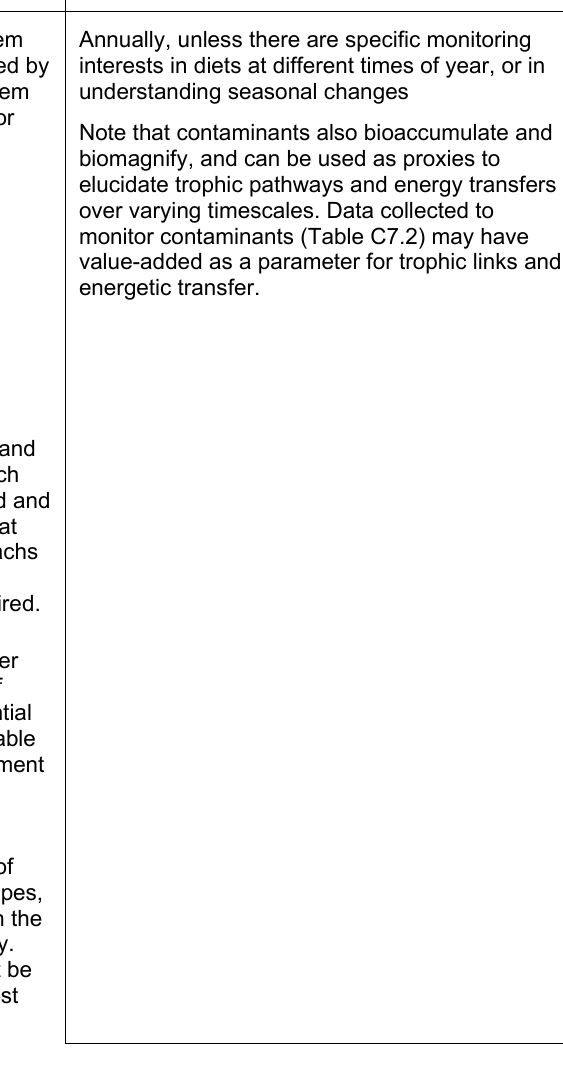
Table C6.1. Key measurement parameters for monitoring trophic links and energetic transfer (Section 6.1).